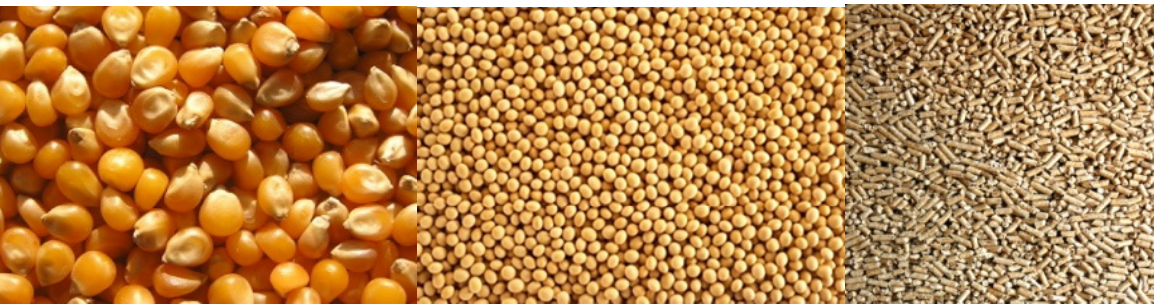
Figure 1. Fuel used for testing—corn, soybeans, wood pellets. Table 1. Proximate and ultimate analysis of the biomass.